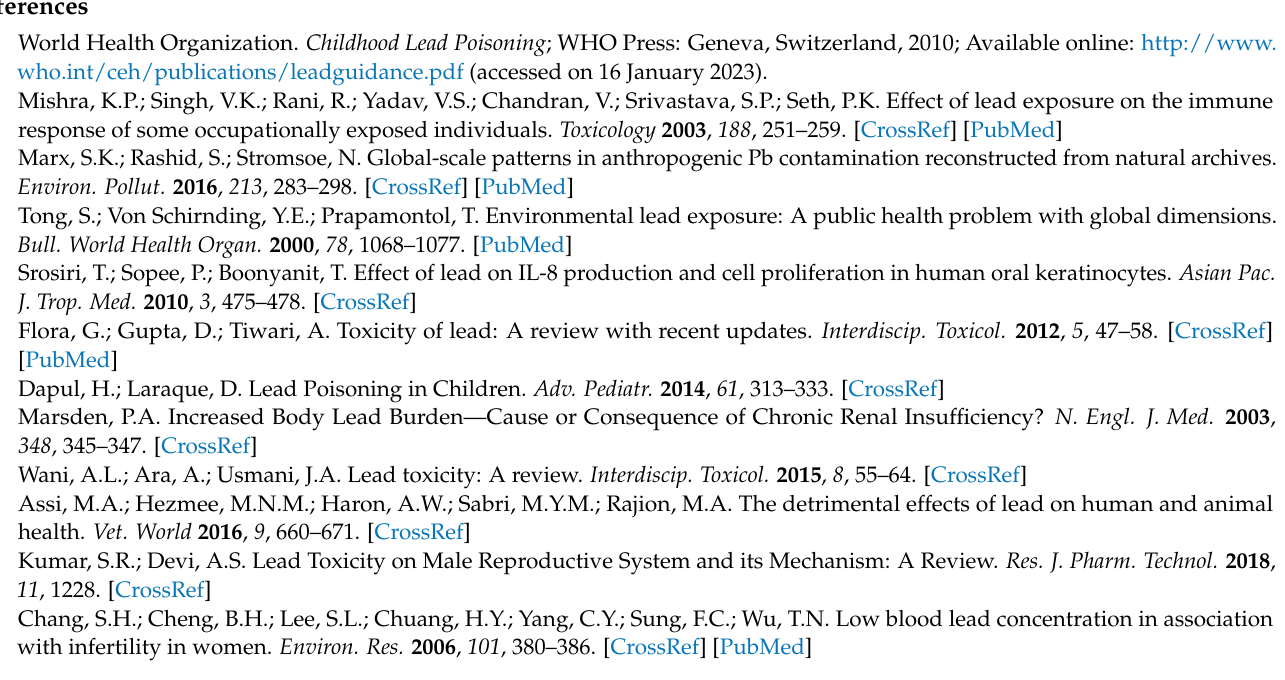
Table S2: Correlations estimated by a Row-wise